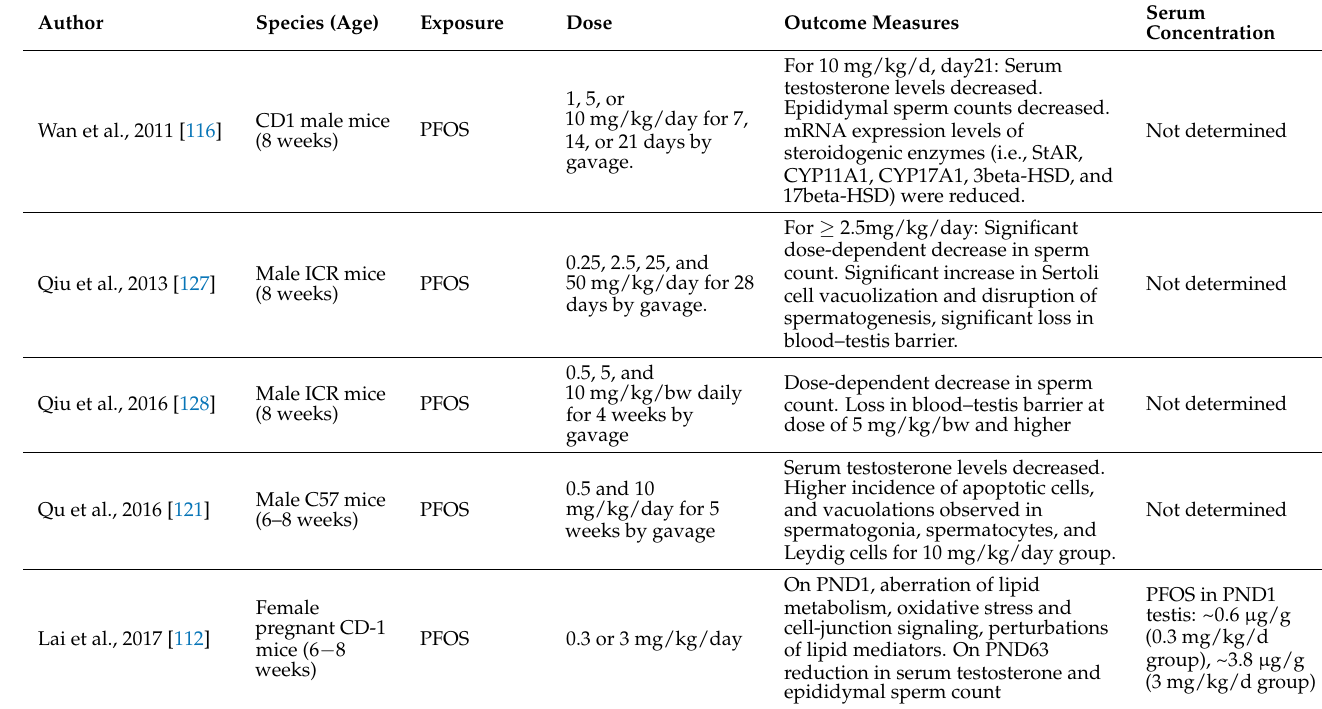
Table 4. PFOS exposure and male fertility measures in